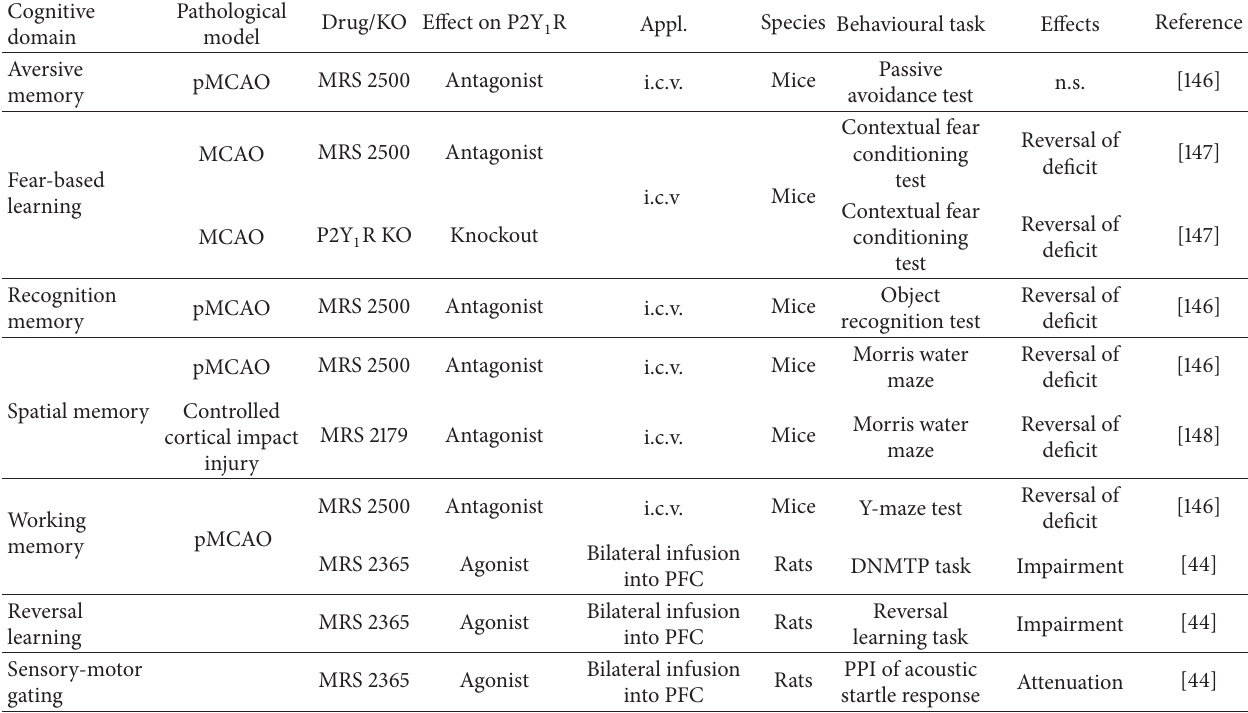
Table 1: Pharmacological or genetic P2Y 1 receptor intervention and cognition in